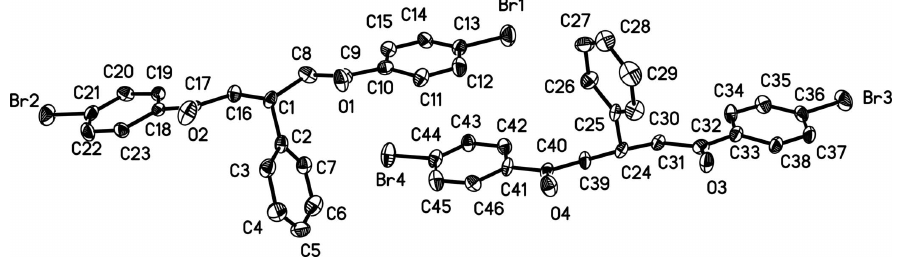
Figure 1 Two independent molecules (I) with the atom numbering scheme and 30% probability displacement ellipsoids. Hydrogen atoms are omitted for